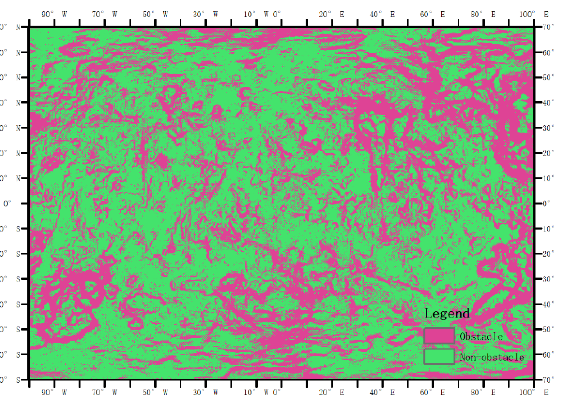
Figure 13. Obstacle distribution map the simulated